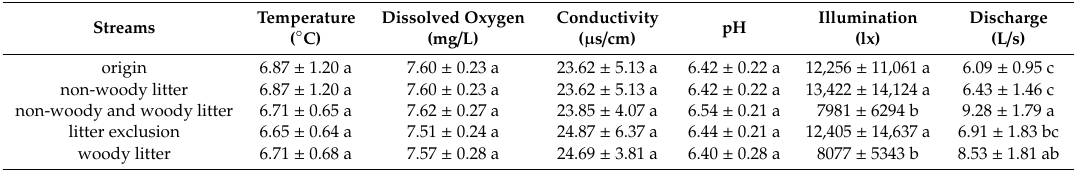
Table 1. Water characteristics of the study streams (average values during the study period, mean ± SE, n =